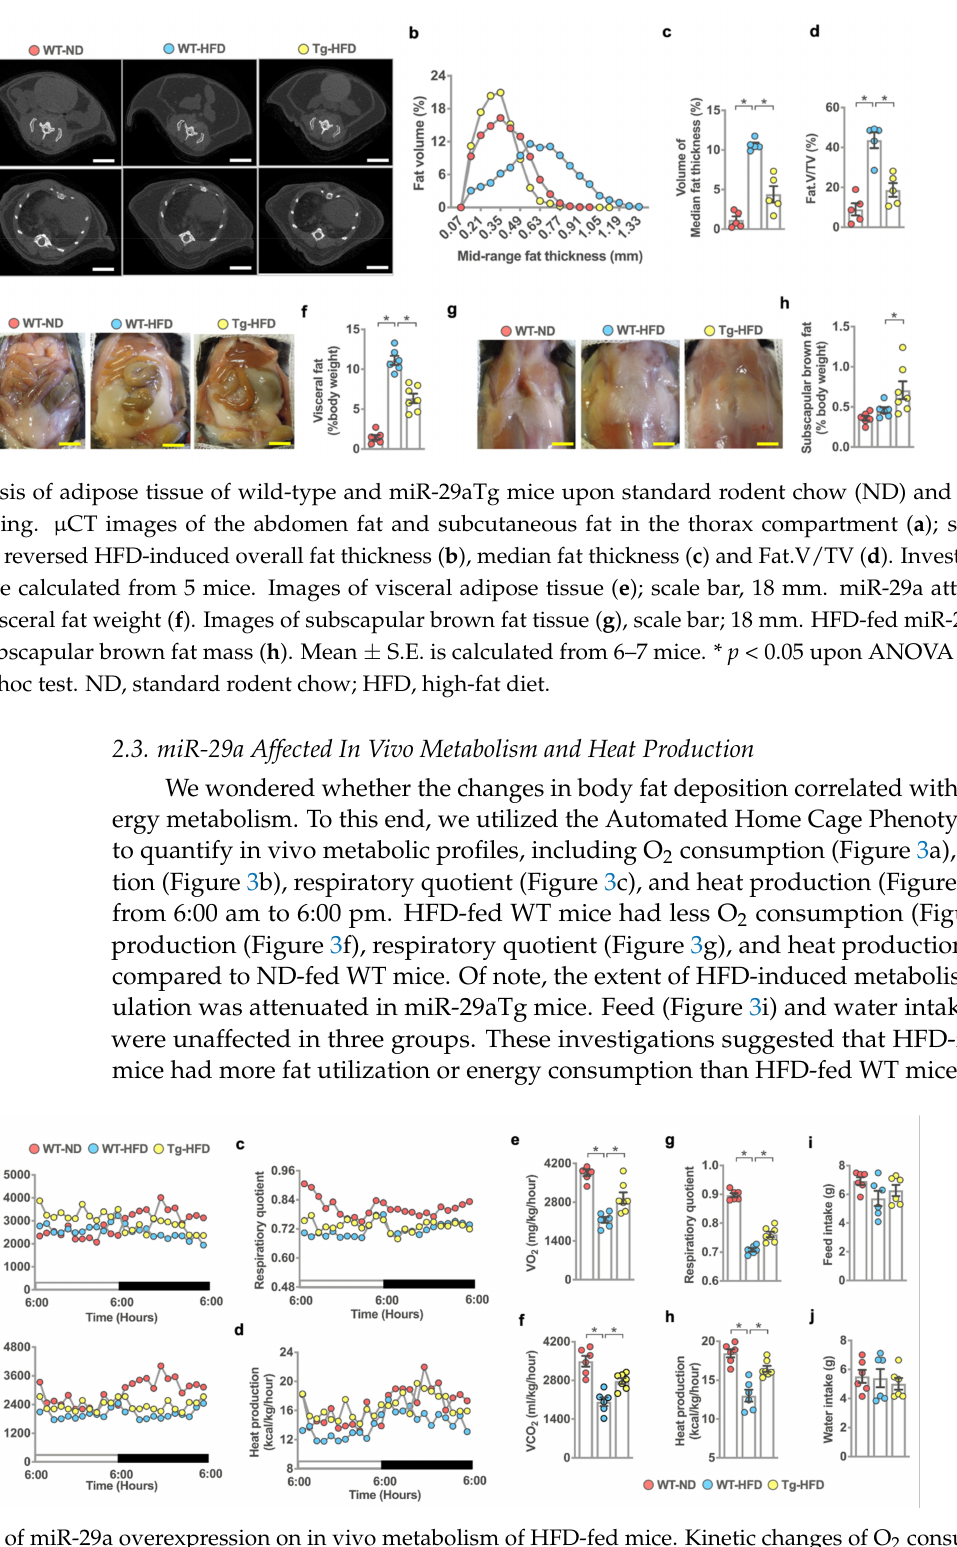
Figure 3. Effects of miR-29a overexpression on in vivo metabolism of HFD-fed mice. Kinetic changes of O 2 consumption ( a ), CO 2 production ( b ), respiration quotient ( c ), and heat production ( d ) of animals accommodated individually in Phenomaster metabolic cages at 23 ◦ C for 24 h. miR-29a overexpression reversed HFD-induced O 2 underconsumption ( e ), CO 2 underproduction ( f ), respiratory quotient repression ( g ), and heat underproduction ( h ), whereas feed ( i ) and water intake ( j ) were unaffected. Mean ± S.E. is calculated from 6 mice. * p < 0.05 upon ANOVA test and Bonferroni post hoc test. ND, standard rodent chow; HFD, high-fat